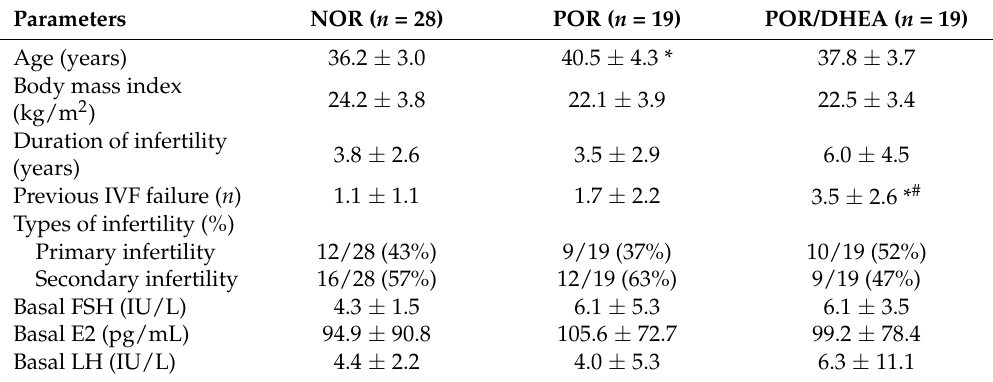
Table 1. Basic characteristics of patients in the NOR, POR, and POR/DHEA